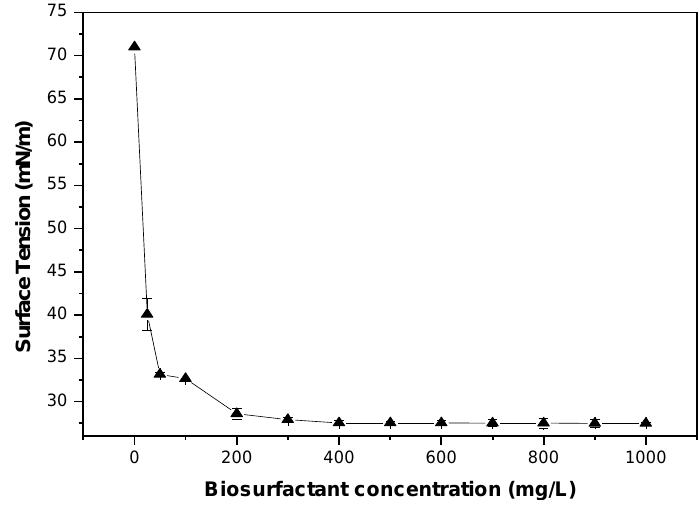
Figure 5. Influence of biosurfactant concentration on surface tension at pH 3.